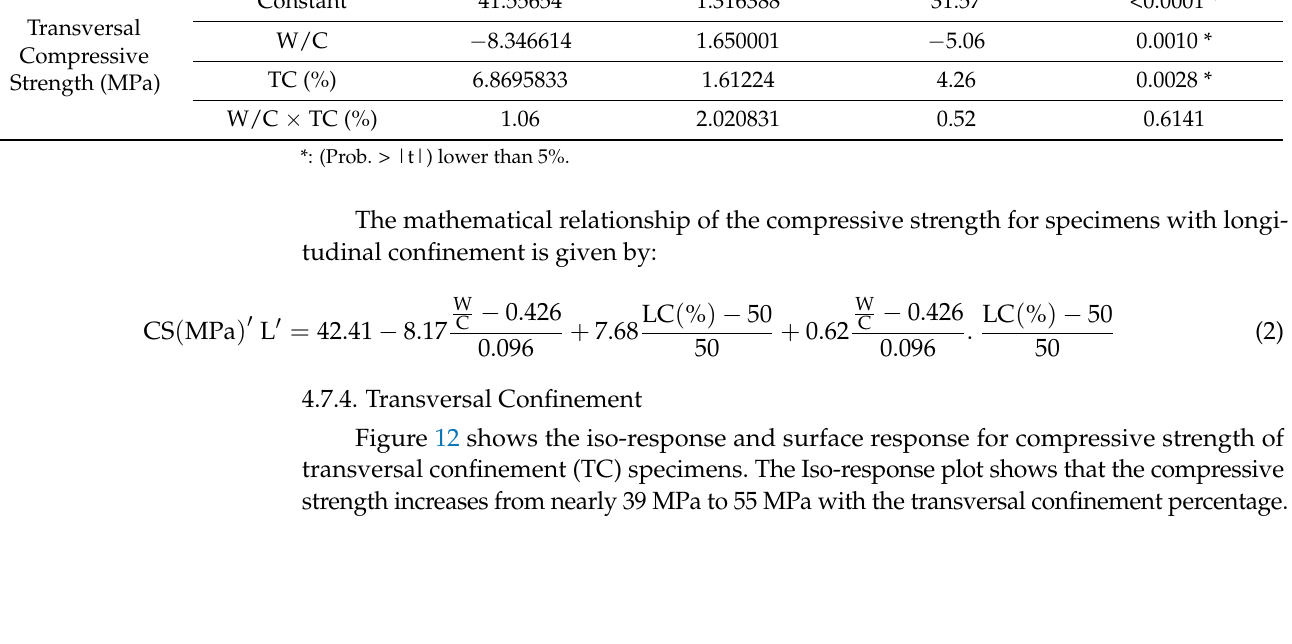
Figure 12. ( a ) Iso response curves and ( b ) response surfaces of the compressive strength of the trans- versal confinement.